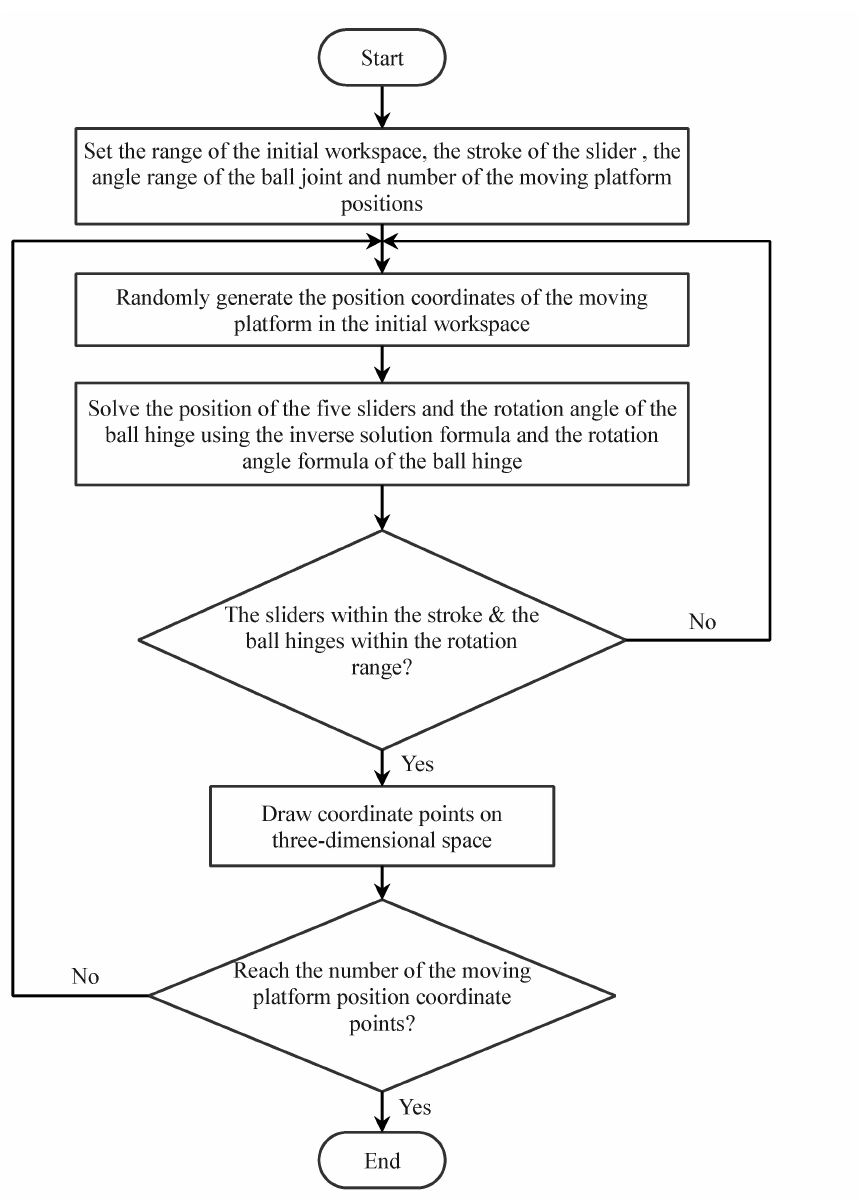
Figure 12. The flowchart of solving mechanism workspace by Monte Carlo